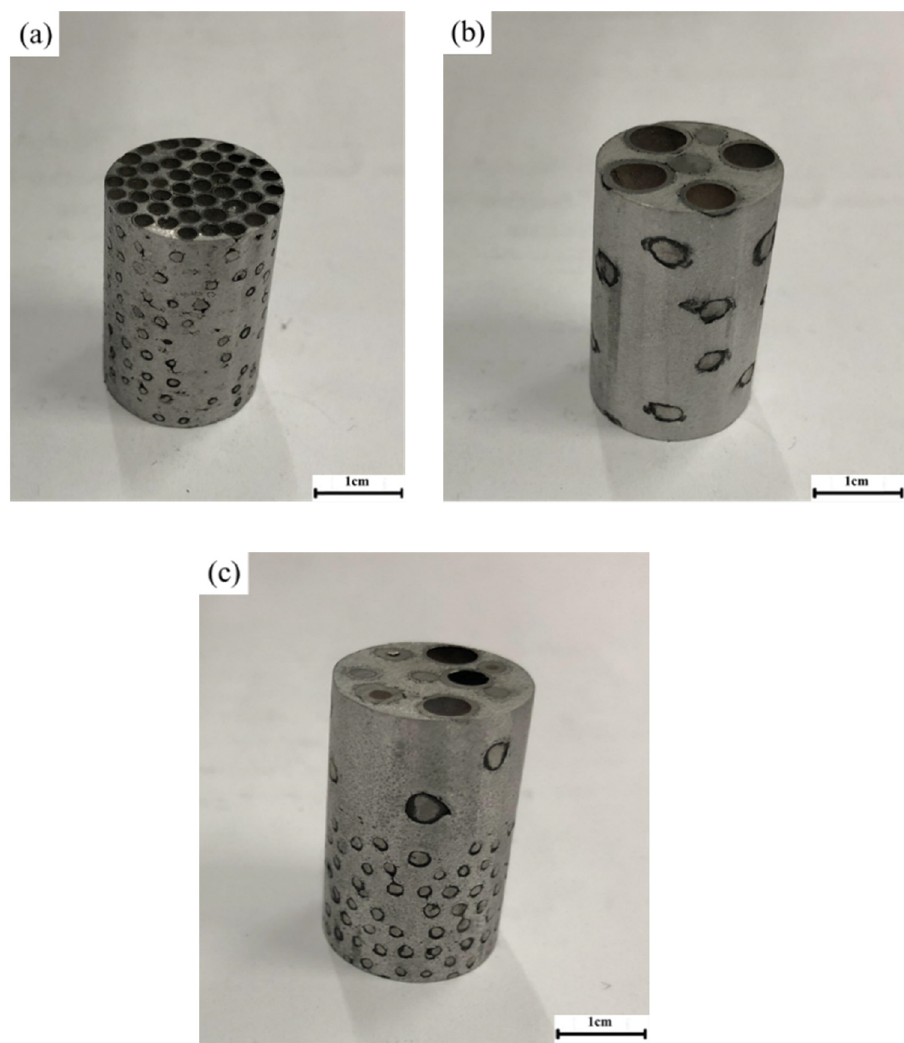
Figure 2: The photos of the MHSCs: ( a ) MHSCs - 2.88, ( b ) MHSCs - 5.76, and ( c ) SG - MHSCs.